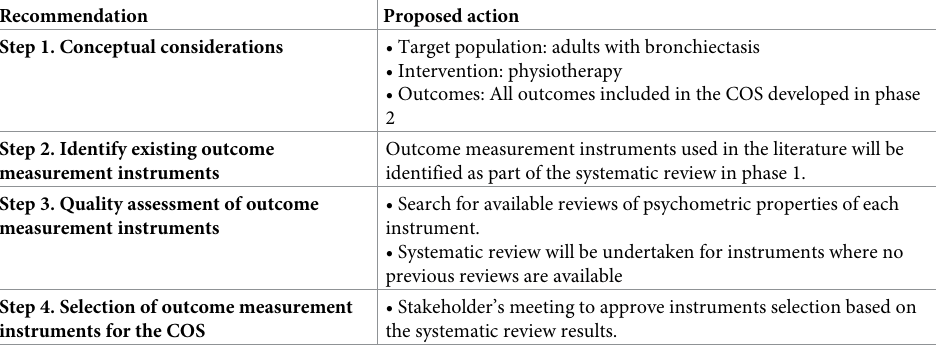
Table 2. Proposed CMS development process based on COSMIN/COMET recommendations [37].